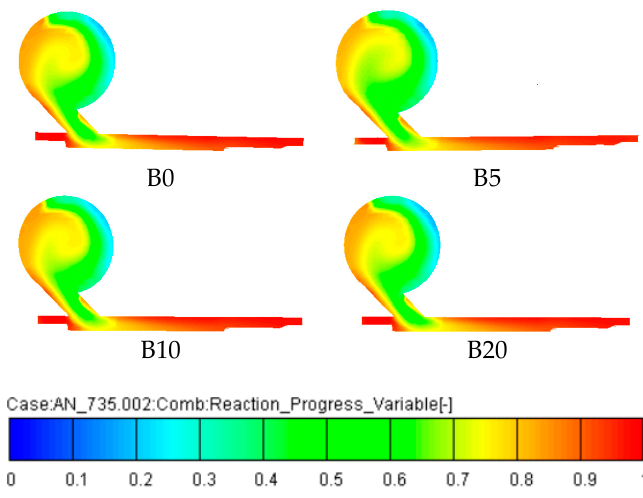
Figure 13. Reaction_Progress_Variable at 13° After Top Dead Centre (ATDC) at 1400 rpm and 100% load.